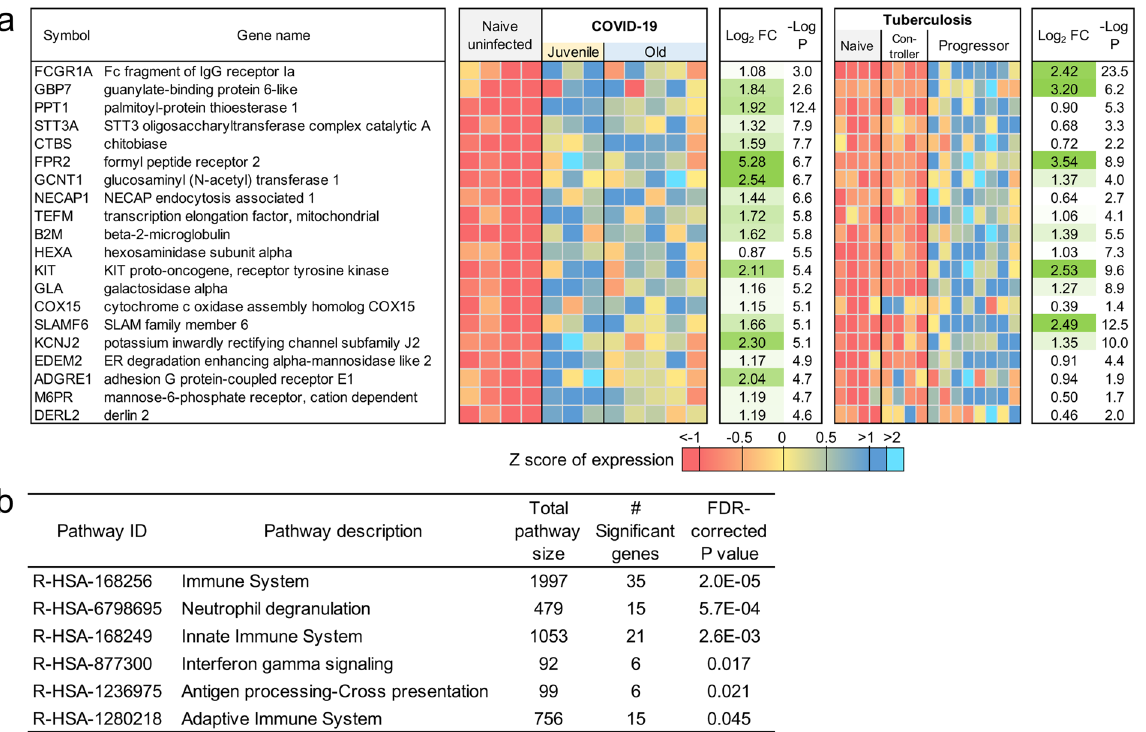
Fig. 9 Genes higher in expression during both COVID-19 and TB share common pathways. a The top 20 (of 97) most signi fi cantly upregulated genes in COVID-19 infected and TB infected macaques. Expression values are visualized by Z scores of normalized expression data (FPKM) per sample, and Log 2 fold change and -Log P values are from the DESeq2 output. Genes are sorted by P value. b Signi fi cant Reactome pathway enrichment among the 97